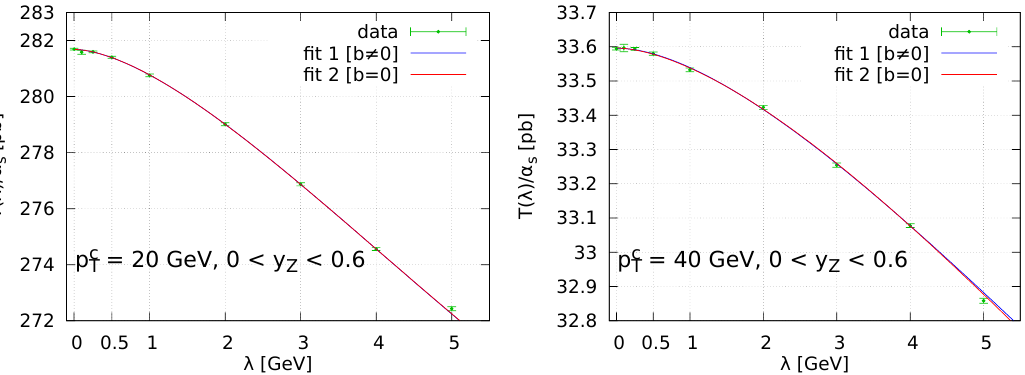
< y c , with y c = 0 . 6 Z